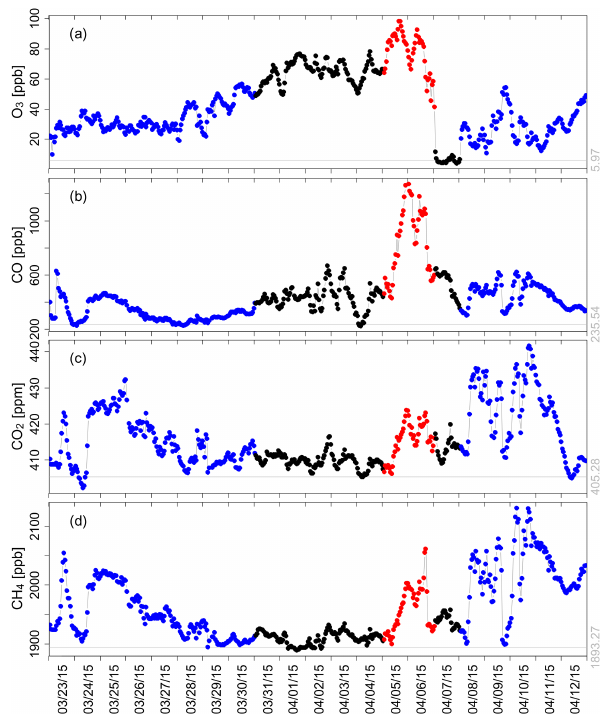
Figure 6. Time series of hourly (a) ozone (O 3 ), (b) carbon monox- ide (CO), (c) carbon dioxide (CO 2 ), and (d) methane (CH 4 ) at PDI during the sampling campaign from 23 March to 12 April 2015. Three colors (green, black, and red) follow the clustergram from the statistical approach discussed in Sect. 3.2.2. Gray lines in the plots indicate the background values, calculated as the mean of the lowest 5% of the dataset during the